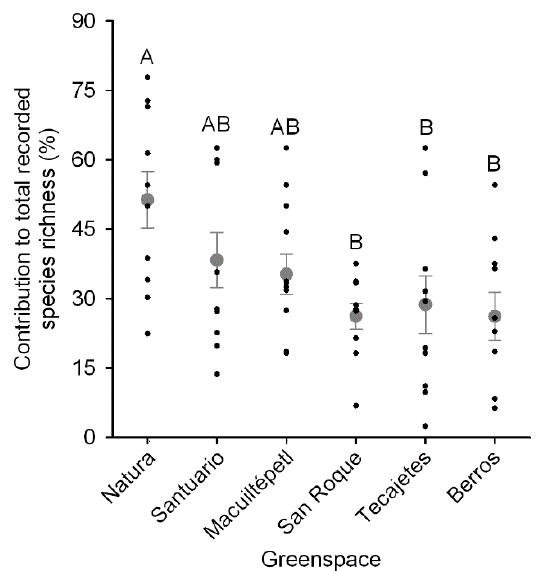
Figure 3. Average greenspace contribution to total species richness of all studied taxonomic groups (error bars represent SE). Black dots indicate the contribution of each taxonomic group per greenspace; letters above values for each greenspace indicate statistically significant differences.